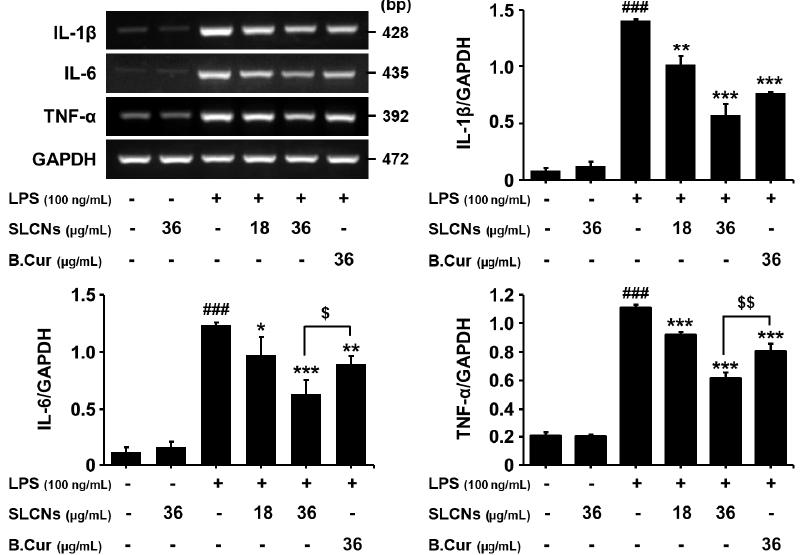
Figure 5. SLCN decreases the production of proinflammatory cytokines. Cells were pretreated with the indicated doses of SLCN and base curcumin for 1 h before LPS (100 ng/mL) treatment. The mRNA levels of TNF- α , IL-1 β , IL-6 and GAPDH were determined via RT-PCR. There was a representative densitometry analysis of TNF- α , IL-1 β and IL-6 compared with GAPDH mRNA, respectively. ### E < 0.001 vs. untreated group; * p < 0.05, ** p < 0.01 and *** p < 0.001 vs. LPS-treated group; $p < 0.05 and $$ p < 0.01 vs. SLCN-treated group (one-way ANOVA; n = 3).